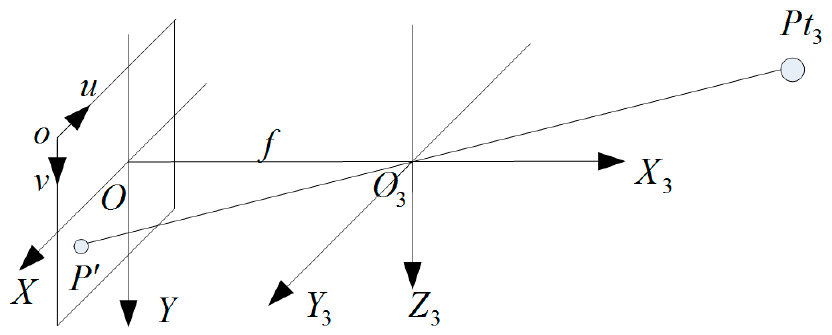
Figure 4. The imaging mapping graph.